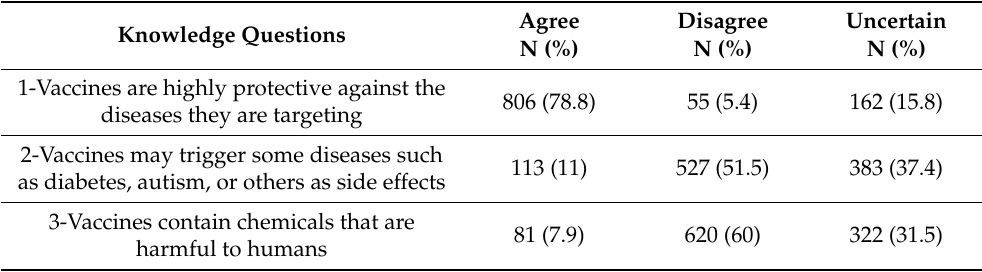
Table 2. Knowledge of subjects toward vaccination. LAUMCRH. January 2020–January